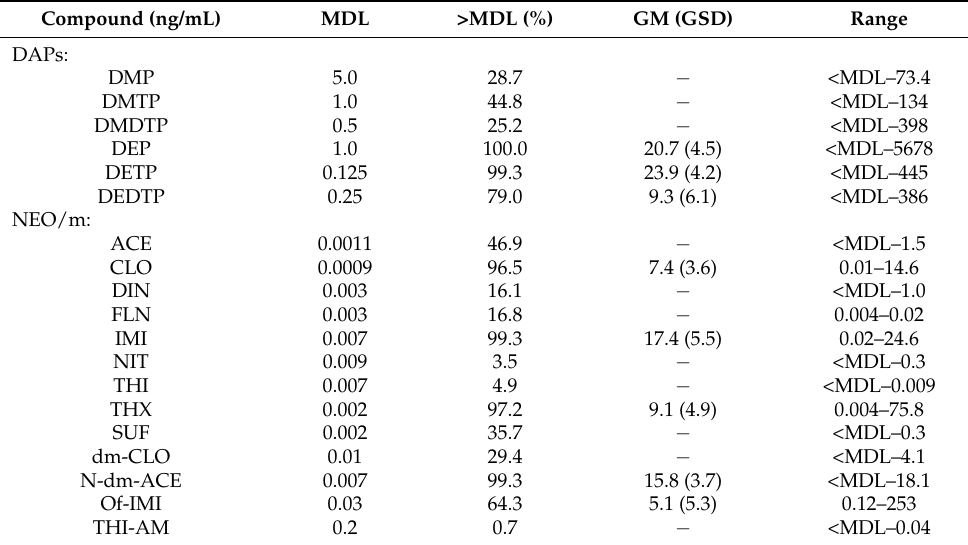
Table 1. Urinary concentrations of dialkylphosphates (DAPs) and neonicotinoids and their metabo- lites (NEO/m) among male farmworkers ( n =